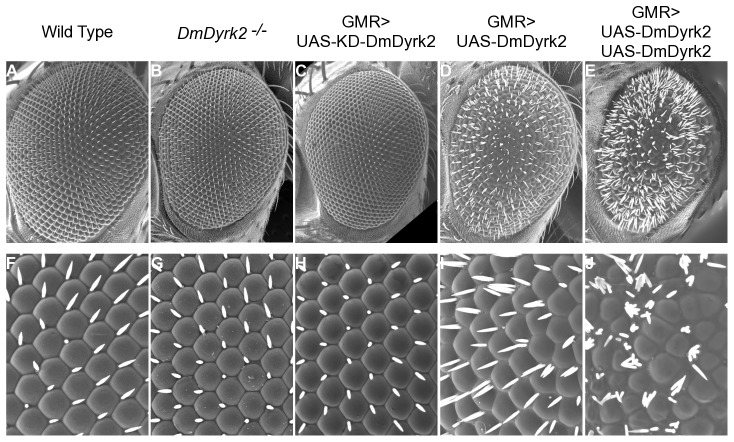
Overexpression of DmDyrk2 in cells following the MF produces a rough eye phenotype.SEM was used to visualize adult eyes from the following genotypes: WT (A and F), DmDyrk2−/− (B and G), GMR-GAL4/+; UAS-DmDyrk2KD/+ (C and H), GMR-GAL4/UAS-DmDyrk2WT (D and I), and GMR-GAL4, UAS-DmDyrk2WT/UAS-DmDyrk2WT (E and J).